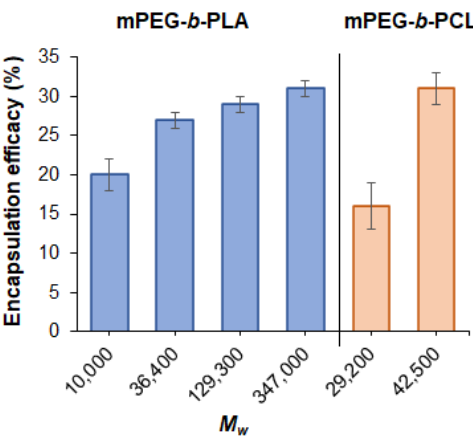
Figure 6. Dependence of the efficacy of dioxadet encapsulation into mPEG- b -PLA and mPEG- b -PCL nanoparticles on the molecular weight of the copolymer (the initial dioxadet amount was 50 µg/mg of polymer).